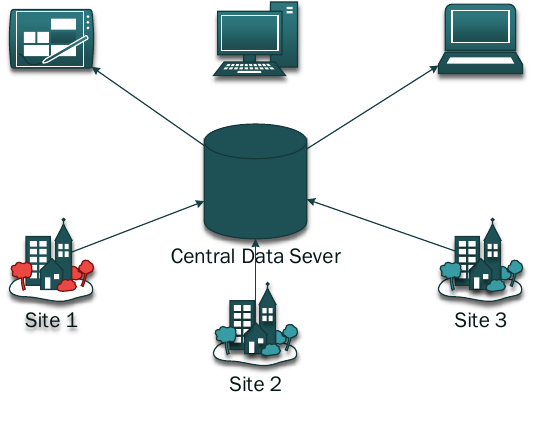
Figure 9. Client/Server